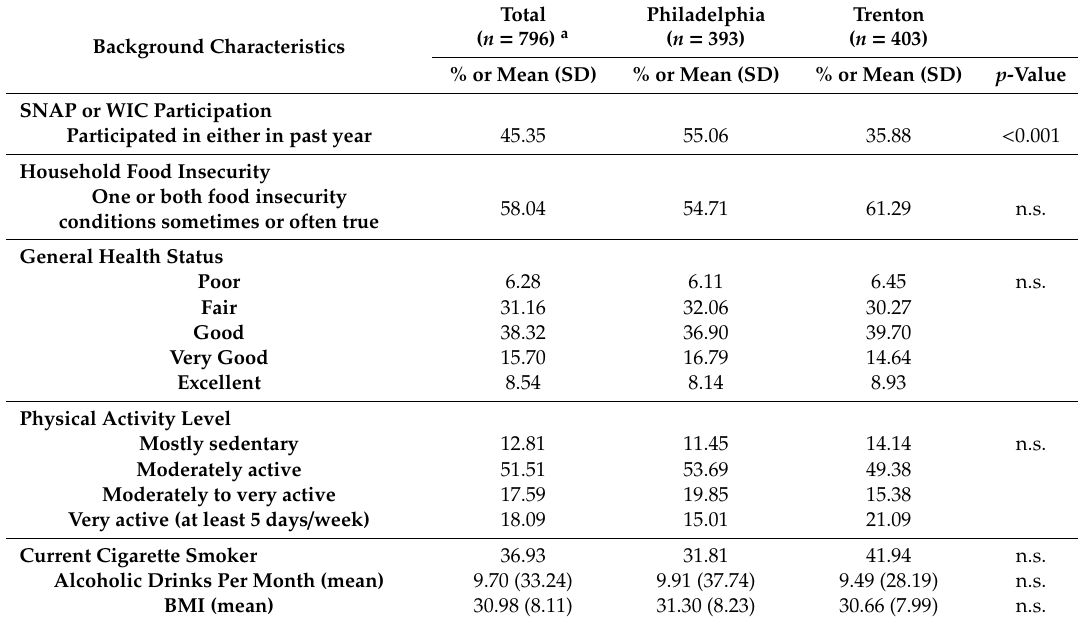
a Table 3 reflects valid percentages. Data were missing for < 2% of the sample for all characteristics listed, except annual household income which was missing (“refused” or “don’t know”) for 12% of the